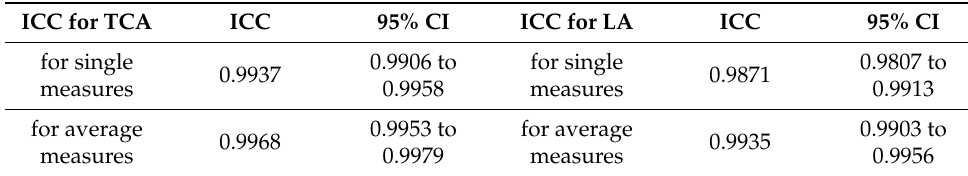
Table 1. Intra-grader reliability assessment of choroidal parameters in 97 subjects. ICC for TCA